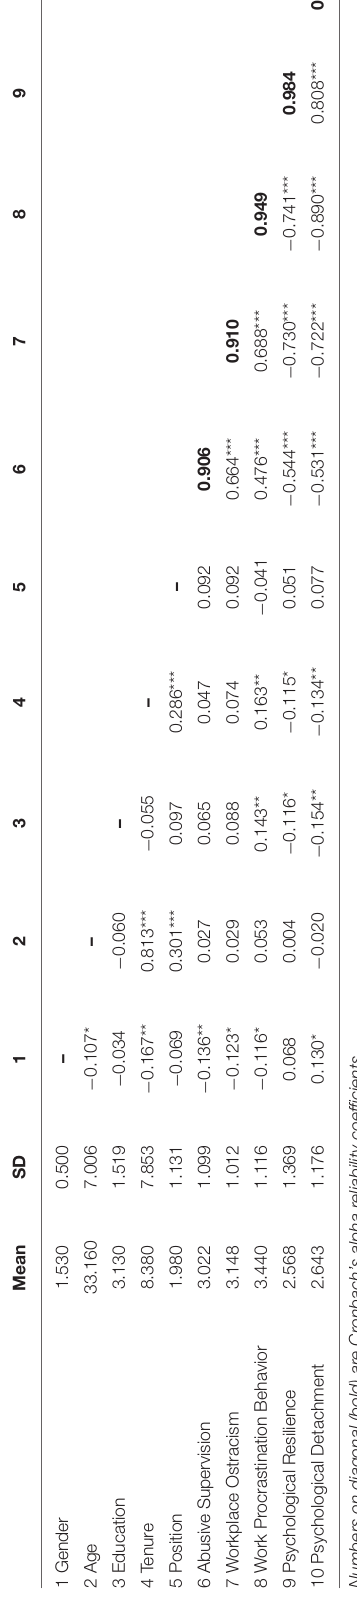
TABLE 3 | Moderating effect of psychological